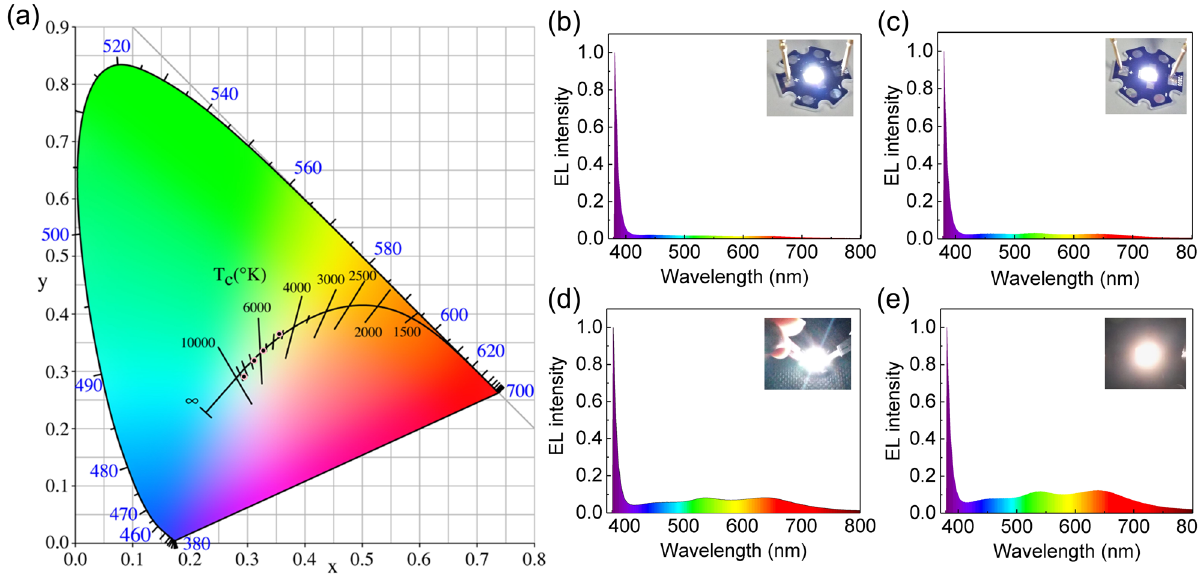
Figure 9: ( a ) The CIE coordinates of WLEDs, whose structure is composed of 0.2, 0.5, 0.8, and 1.1 mL SCWE - CQDs and UV - LED ( 395 nm ) chip. The electroluminescence ( EL ) pattern of the WLEDs device prepared by diluting ( b ) 0.2 mL, ( c ) 0.5 mL, ( d ) 0.8 mL, and ( e ) 1.1 mL of the SCWE - CQDs, insets are the working images of devices.